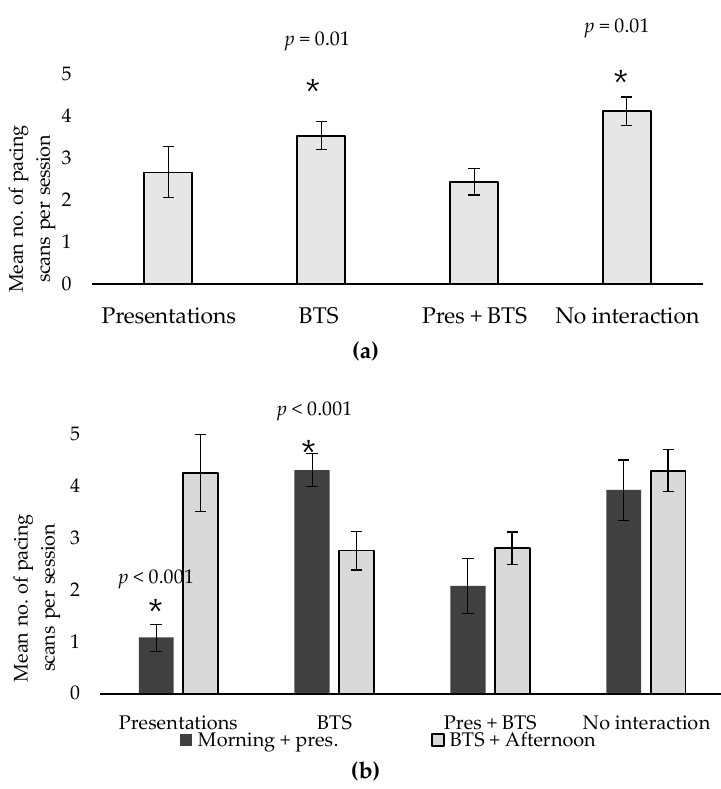
Figure 2. ( a ) Mean number of scans where pacing was observed during any given observation session across the four treatments. Error bars show standard error. Asterisks denote significant treatment differences. ( b ) Mean number of scans where pacing was observed during the two different observation blocks across the four different treatments. Pres–Presentations; BTS–Behind the Scenes Error bars show standard error. Asterisks denote significant treatment/session interactions.